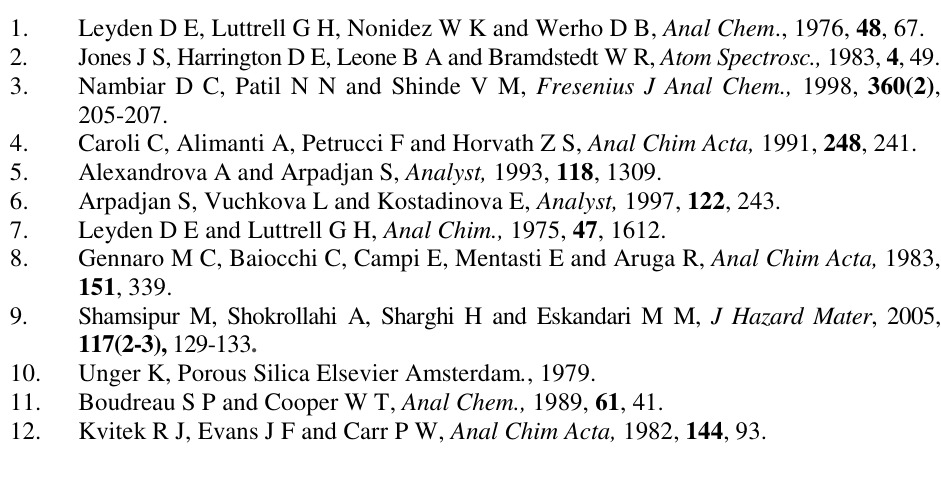
a Values are corrected for blank concentration of water samples and based on triplicate